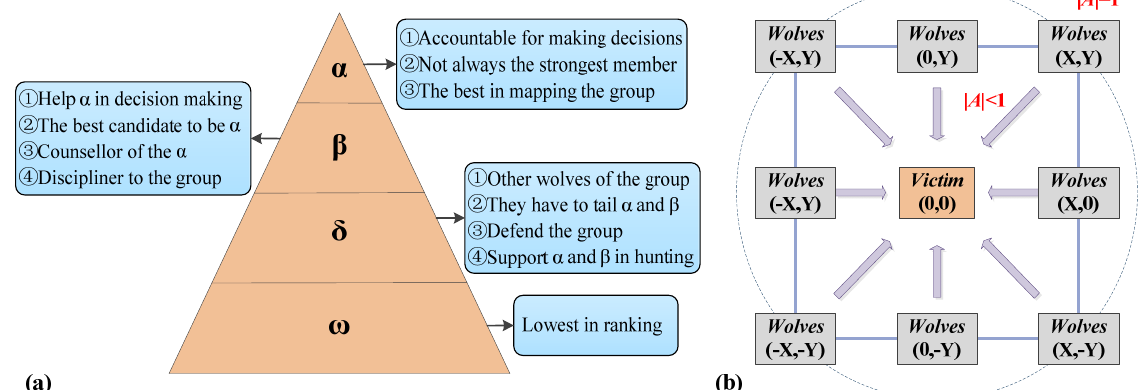
Figure 4. The grey wolf optimizer (GWO) algorithm: ( a ) in the social hierarchy of grey wolves; ( b ) the current positions of the grey wolves and victim respectively.